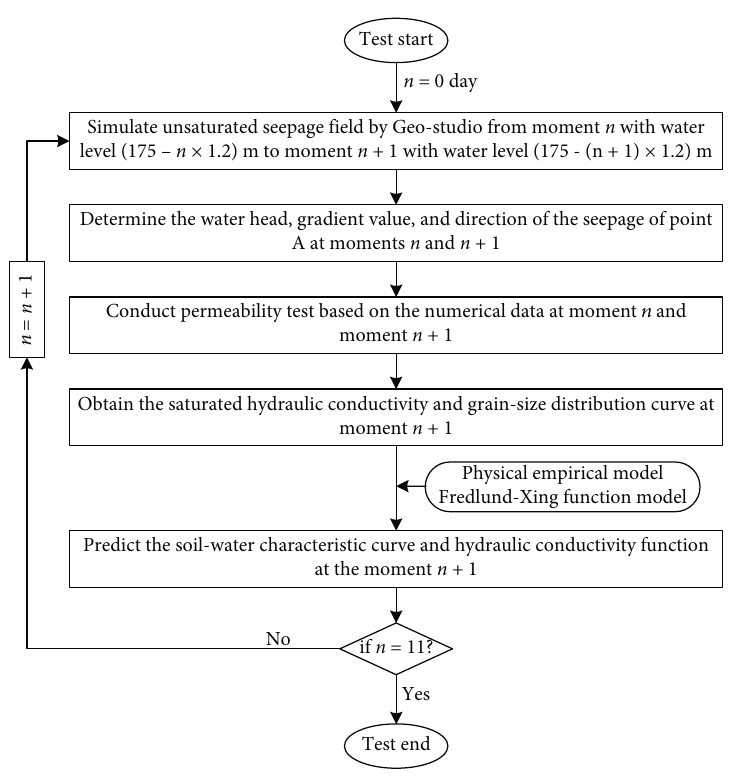
Figure 6: Flow chart of the test